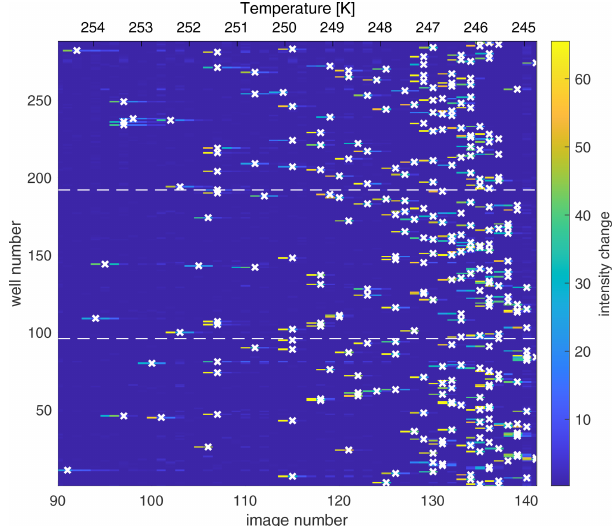
Figure 2. Map of the change in light intensity for each of the 288 wells ( y axis) as a function of the image number ( x axis), recorded every 0.2 ◦ C and corresponding to temperature decreasing and ex- perimental time progressing. (The first 90 images corresponding to an interval of 18 ◦ C are excluded here for simplicity). The color scale represents the first derivative of the light intensity, with bright colors indicating a sudden drop in light intensity associated with freezing of the well. The algorithm assigns the freezing temperature of the well to the greatest change in light intensity and is marked by a white “x”. The dashed horizontal lines indicate the tray bound- aries between the three Piko PCR trays. The freezing experiment depicts the results of a background water